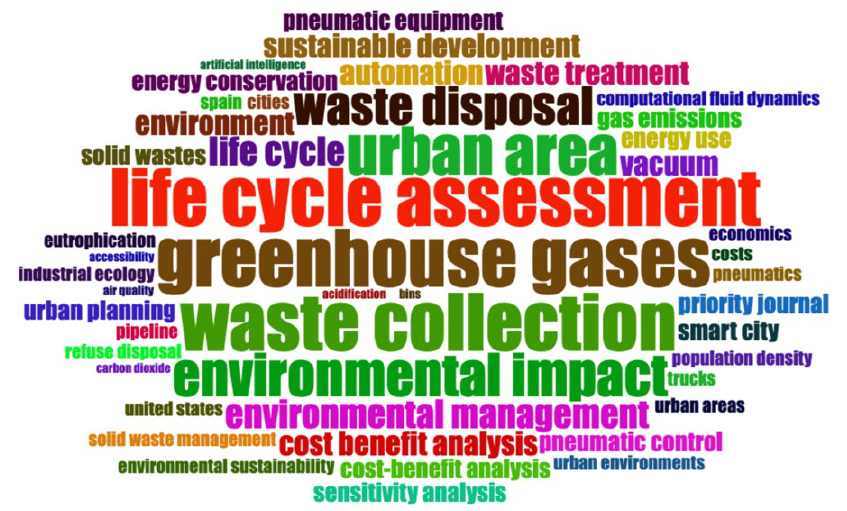
Figure 6. Word cloud of the author’s keywords extracted from the database analysed using R-studio software and bibliometrix library of the automated waste collection system (AWCS) scientific literature found in Scopus.